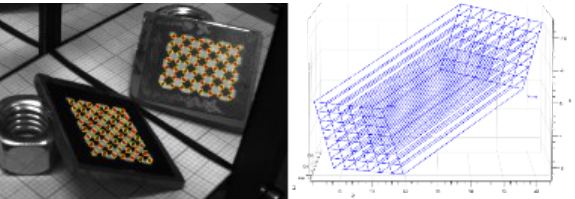
Figure 8: Left: Chessboard corners detected at the real and virtual chessboards, and Right: 3D symmetry lines.